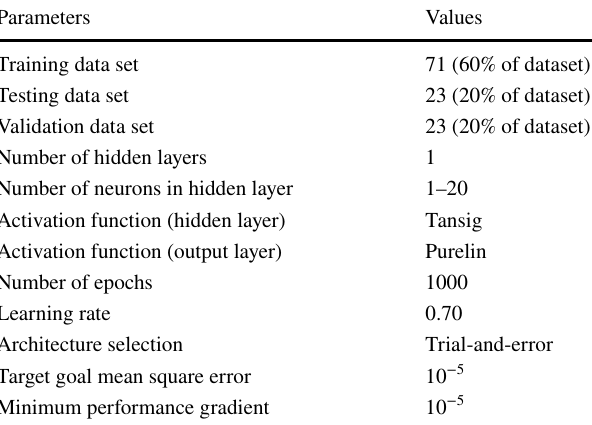
Table 5 Parameter settings for ANN model